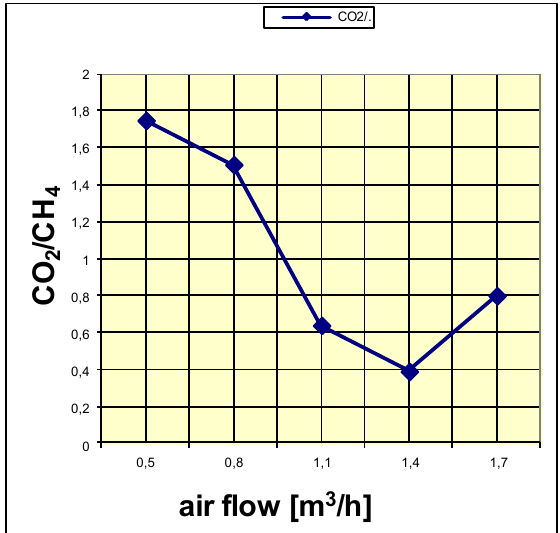
Fig. 7. Characteristics of the methanation process - the degree of conversion of CO 2 to CH